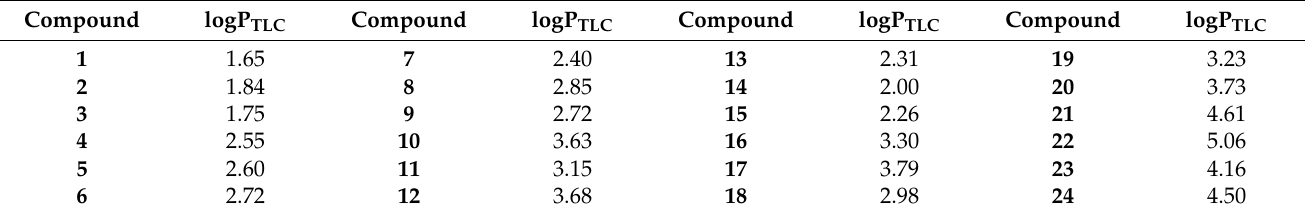
Table 3. The experimental lipophilicity (logP TLC ) for compounds 1–24